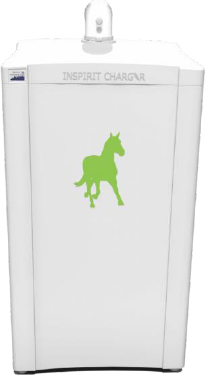
Fig. 4. CHP Inspirit Stirling engine, power 1 kWe [8] WhisperGen is distinguished by a lower electric power.